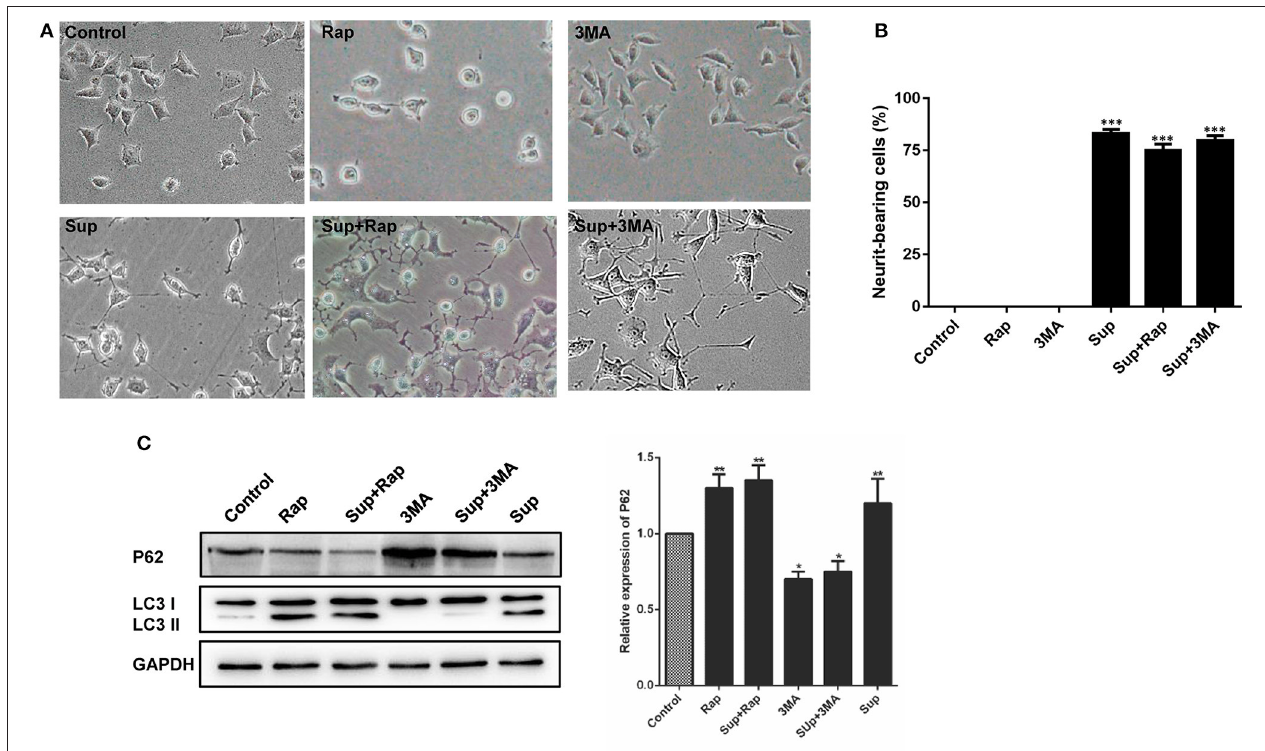
FIGURE 6 | Autophagy did not affect neurite outgrowth in PC12 cells. (A) The expression of the autophagy markers P62 and LC3 were determined by western blot analysis in PC12 cells; (B) PC12 cells morphology changed and (C) neurite-bearing cells counted after treatment with M. smegmatis culture supernatant (Sup), the autophagy inducer rapamycin (1 µ M, Rap), the autophagy inhibitor 3-MA (10mM, 3-MA), Sup + Rap, and Sup + 3-MA. (20 × ) for 48h. Quantitative results were presented as means ± S.D. for 3 replicates. * P < 0.05, ** P < 0.01, *** P < 0.001 vs. control group, n =